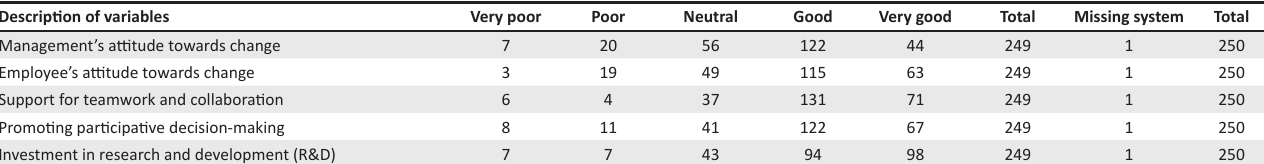
TABLE 5: Using only